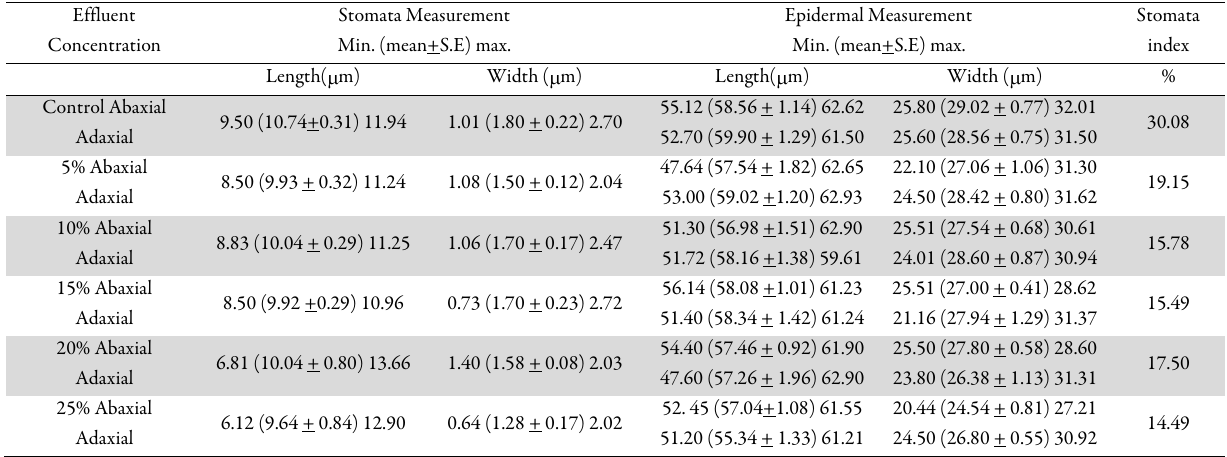
Table 9. Quantitative foliar characters of the studied Solanum lycopersicum treated with different concentrations of effluent Effluent